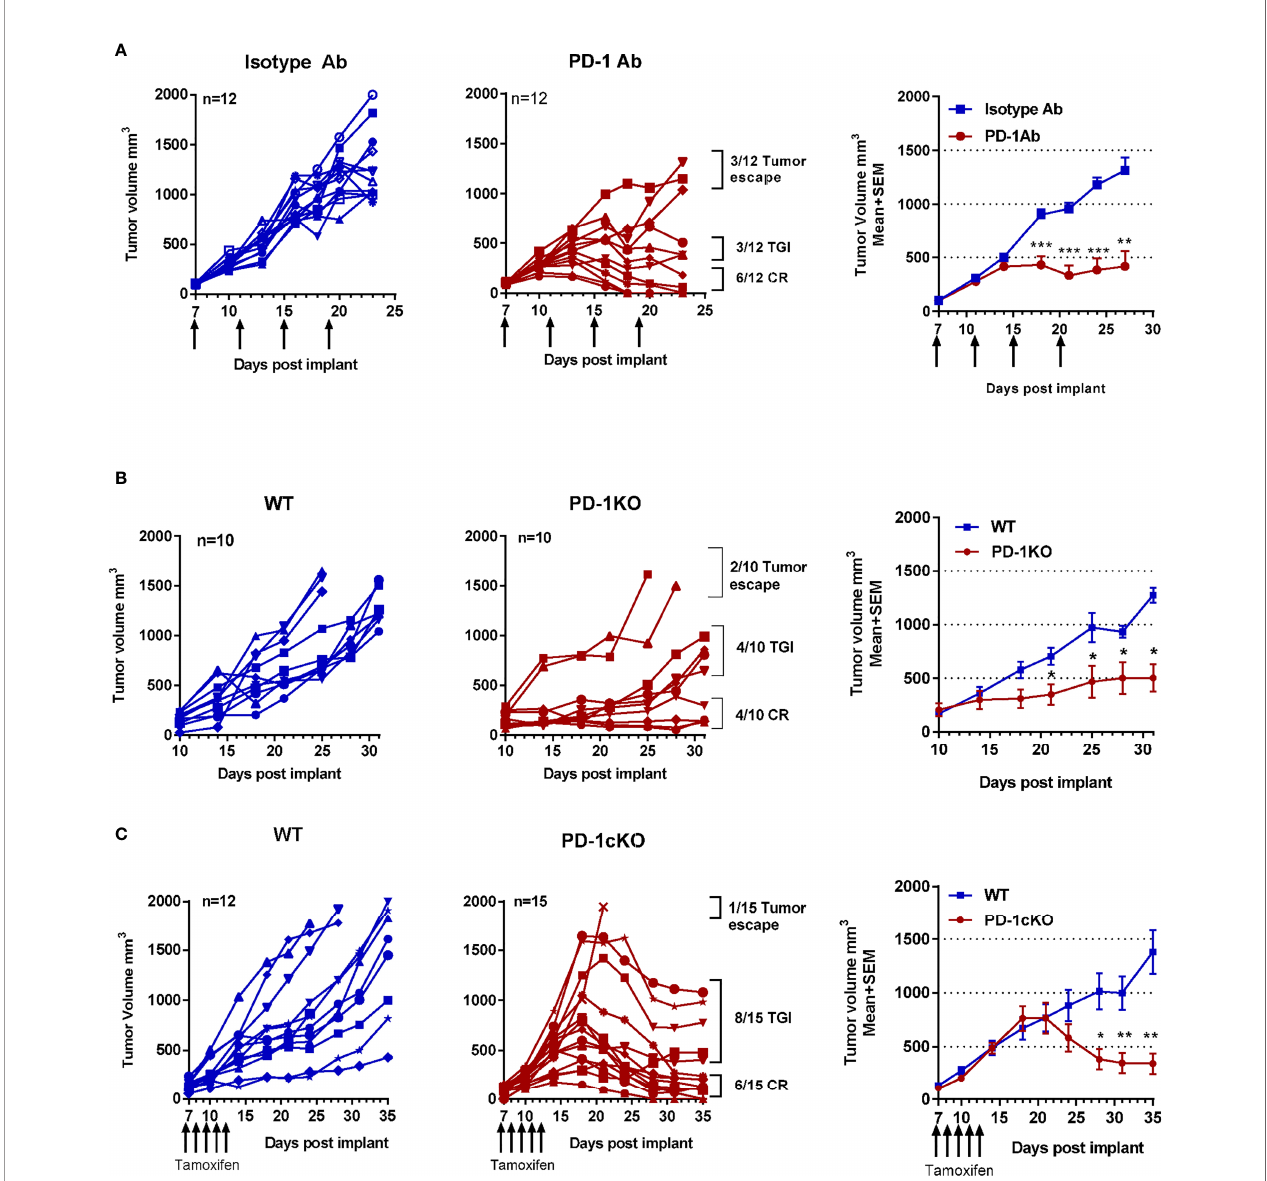
FIGURE 1 | Deletion of PD1 in adult mice results in regression of MC-38 tumors, immunity, and long-term antigen-speci fi c memory. MC-38 tumor size plotted for individual mice and as mean ± SEM for the group. (A) WT mice after treatment with PD-1 or isotype antibody. (B) PD-1KO and WT control mice. (C) PD-1cKO mice and littermate controls after treatment with tamoxifen. Arrows indicate time point of PD-1 Ab or tamoxifen treatment. Data representative of three independent experiments with n = 7 – 8 mice per experiment and group. *p < 0.05, **p < 0.01, ***p < 0.001. TGI, tumor growth inhibition; CR, complete response. See also Supplementary Figure S1